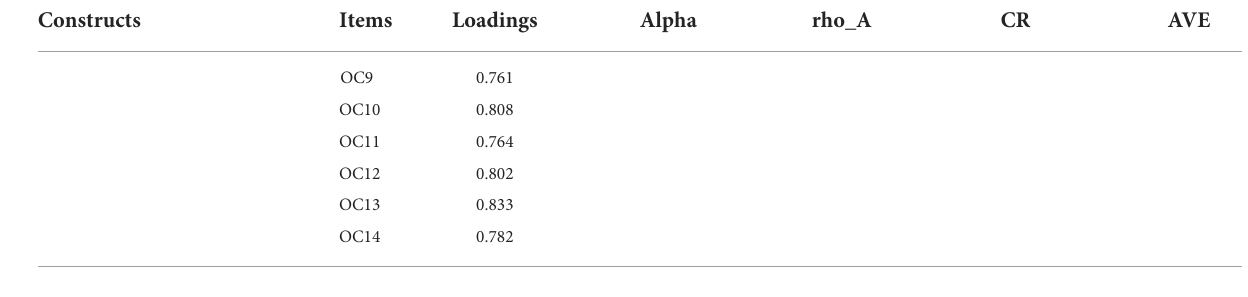
TABLE 4 Discriminant validity (HTMT ratio).